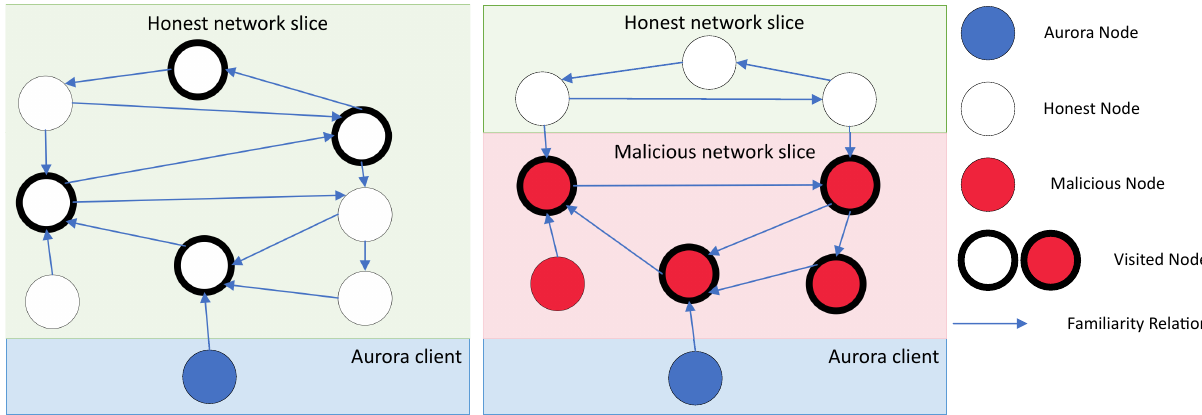
Figure 1. The figure on the left shows a client running the Aurora algorithm as it traverses the honest part of the network. The right figure shows the client traversing a malicious